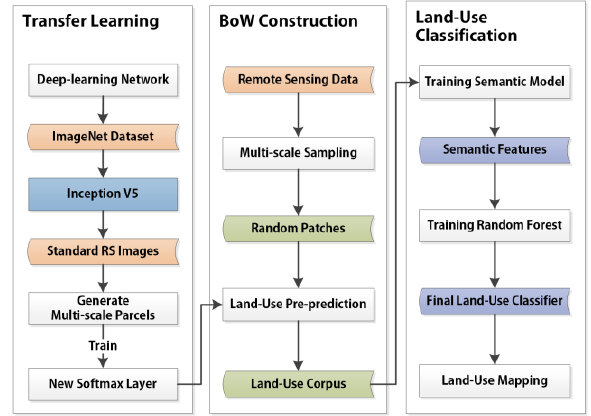
Figure 3. Flowchart of the proposed model for classifying urban land use by integrating Google Tensorflow and scene classification.